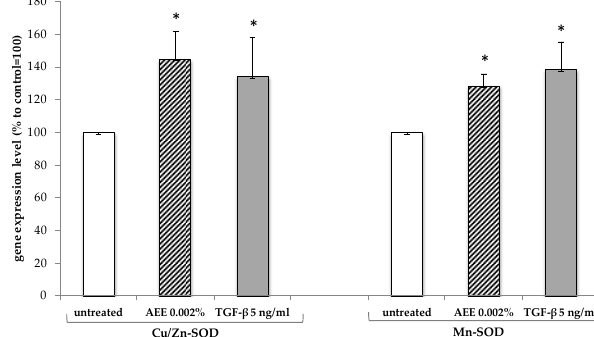
Figure 2. Effect of AEE on Superoxide Dismutases (SOD) in lymphatic endothelial cells. The gene expression level of the Cu/Zn-SOD and Mn-SOD was measured in HDLEC incubated with AEE or TGF- β , used as positive control. All determinations were conducted in triplicate and the results are expressed as mean ± SD. * p < 0.05.